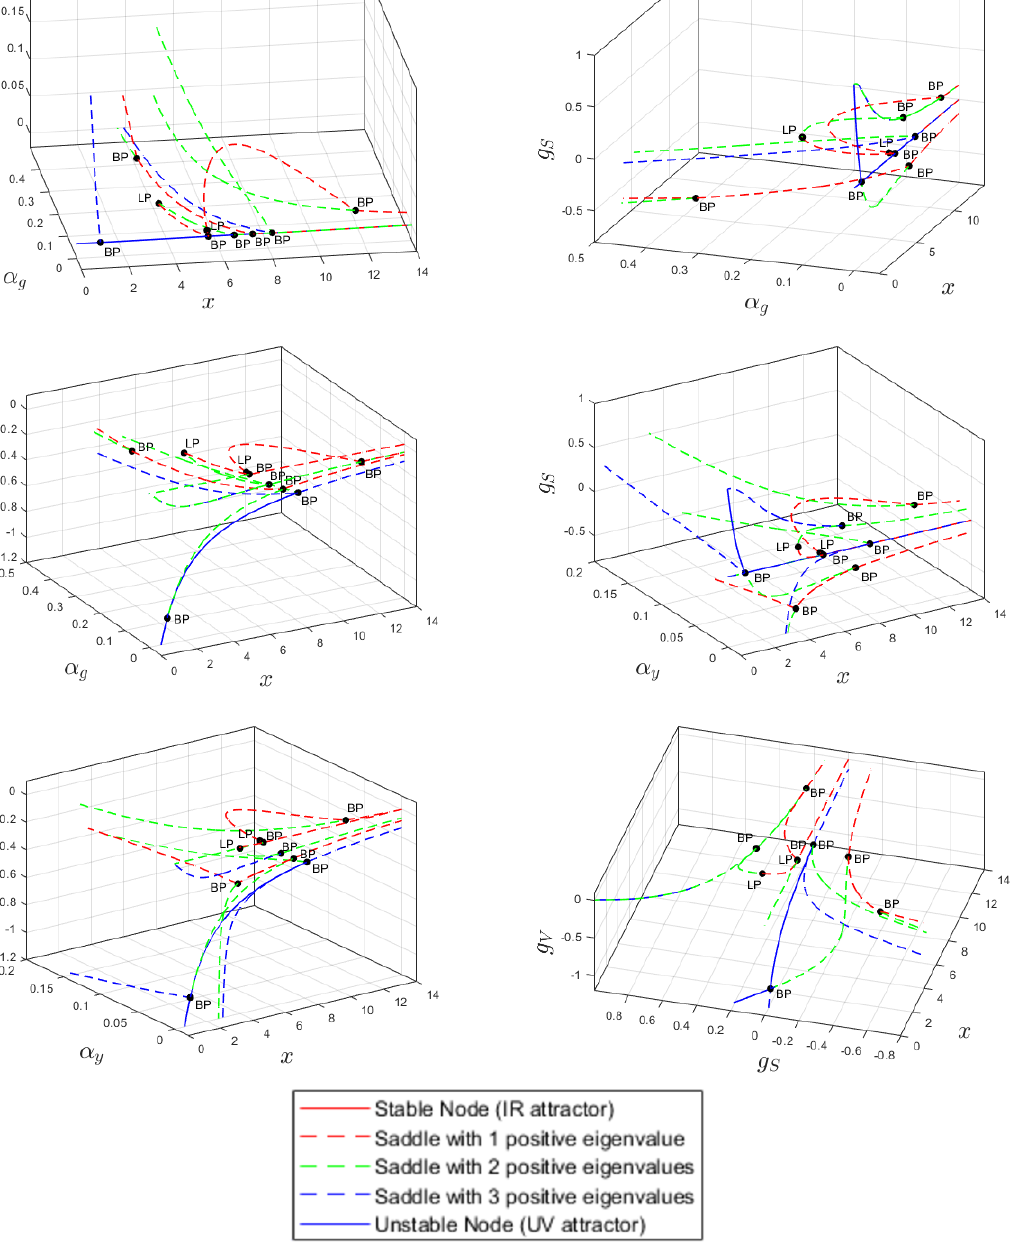
Figure 18. The equilibria of the RG-(cid:13)ow of (3.5) projected on the ( x; (cid:11) space, ( x; (cid:11) g ; g V )-space, ( x; (cid:11) y ; g S )-space, ( x; (cid:11) y ; g V )-space and the ( x; g S ; g V )-space. LP: Limit Point. BP: Branching Point.